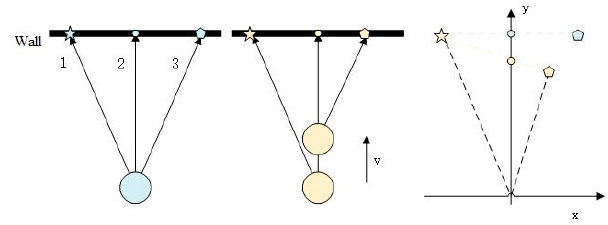
ff ect of ego-motion on scan Figure 1. The effect of ego-motion on scan skewing. Figure 1. The e